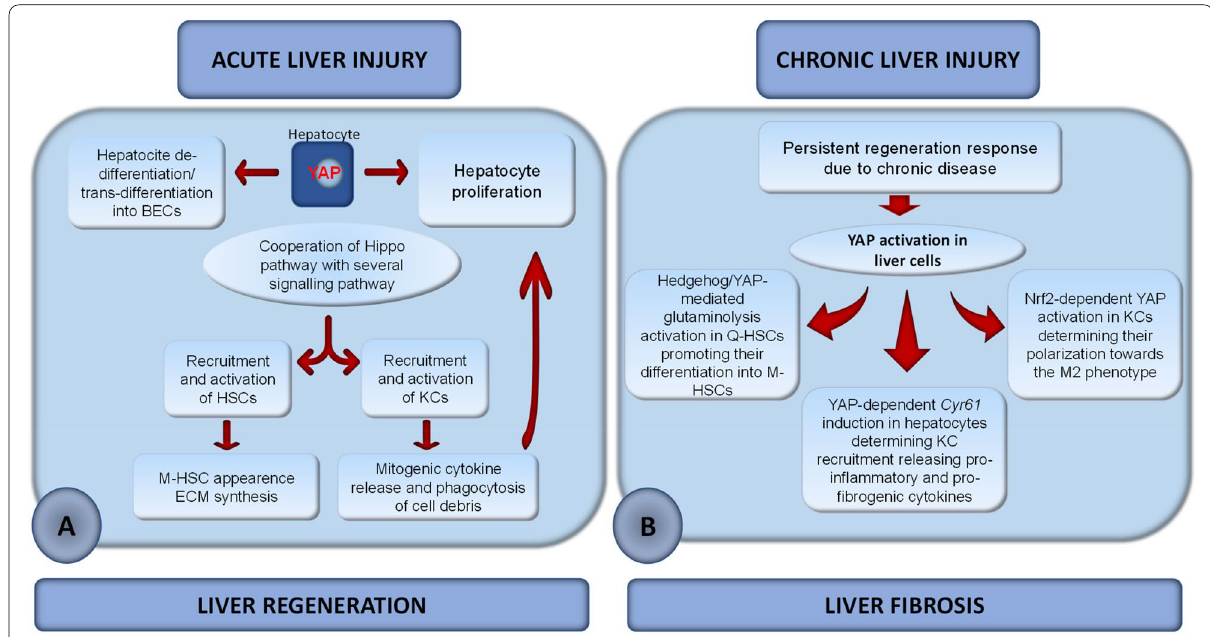
Fig. 7 Schematic representation of the role of YAP/TAZ in normal and chronic injured liver. In normal liver ( A ), YAP activation after liver injury induces liver regeneration by promoting the formation of a new bile duct network through direct BEC proliferation or/and hepatocyte dedifferentiation to HPCs which can trans-differentiate to BECs. The creation of a new bile duct network is necessary to prevent cholestasis which impairs liver regeneration by affecting immune cell recruitment and function. Once activated in hepatocytes, YAP/TAZ signaling interacted with other signaling pathways, which mediate the recruitment and induction of KCs releasing mitogenic cytokines for parenchymal and/or non-parenchymal cells. Activated KCs also operate the phagocytosis of cell debris to allow a proper tissue regeneration. In addition, Hedeghog/ YAP-mediated activation of HSCs promotes liver regeneration through ECM protein synthesis. In chronic diseased liver ( B ), where the predetermined threshold for proper liver regeneration is exceeded, YAP activation promotes a wound healing response. Indeed, chronic disease induces a persistent regeneration response in the liver, which is associated to extensive accumulation of ECM and disruption of normal hepatic structure and function. Thus, YAP activation in liver cells results in a reparative process which is characterized by liver fibrosis development, due to (i) Hedgehog/ YAP-mediated glutaminolysis activation in quiescent HSCs which promote their differentiation into myofibroblastic HSCs; (ii) YAP-dependent Cyr61 gene induction in hepatocytes which determine the recruitment of macrophages in the injured liver that release inflammatory and pro-fibrogenic cytokines; (iii) Nrf2-dependent YAP activation which is associated to inhibition of NLRP3 inflammasome in macrophages determining their polarization toward the M2 phenotype associated to the release of anti-inflammatory and reparative